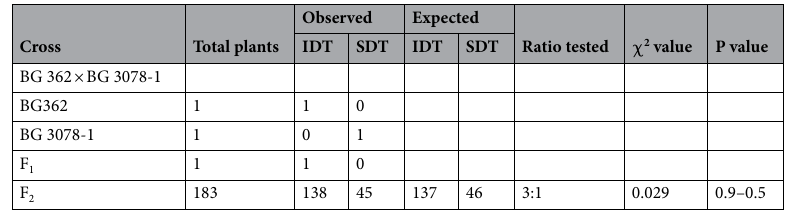
Table 1. Segregation for stem growth habit in F 2 of a chickpea cross involving indeterminate and semi- determinate parents.